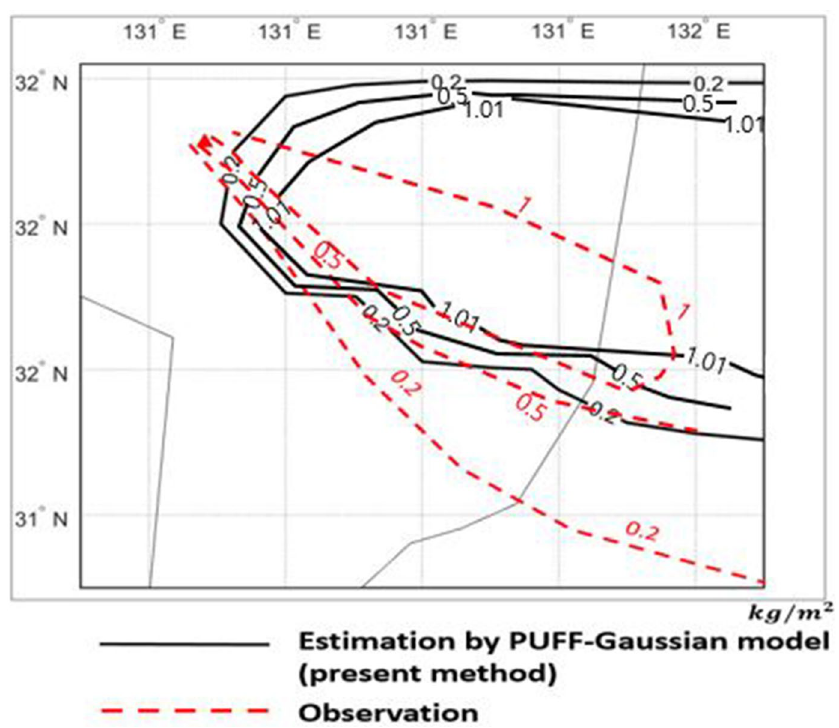
Figure 11. Comparison of ash deposition from the Shinmoedake volcano eruption from Jan. 26 to 27, 2011 between observations and the PUFF–Gaussian model for 0.2 kg / m 2 , 0.5 kg / m 2 , 1 kg / m 2